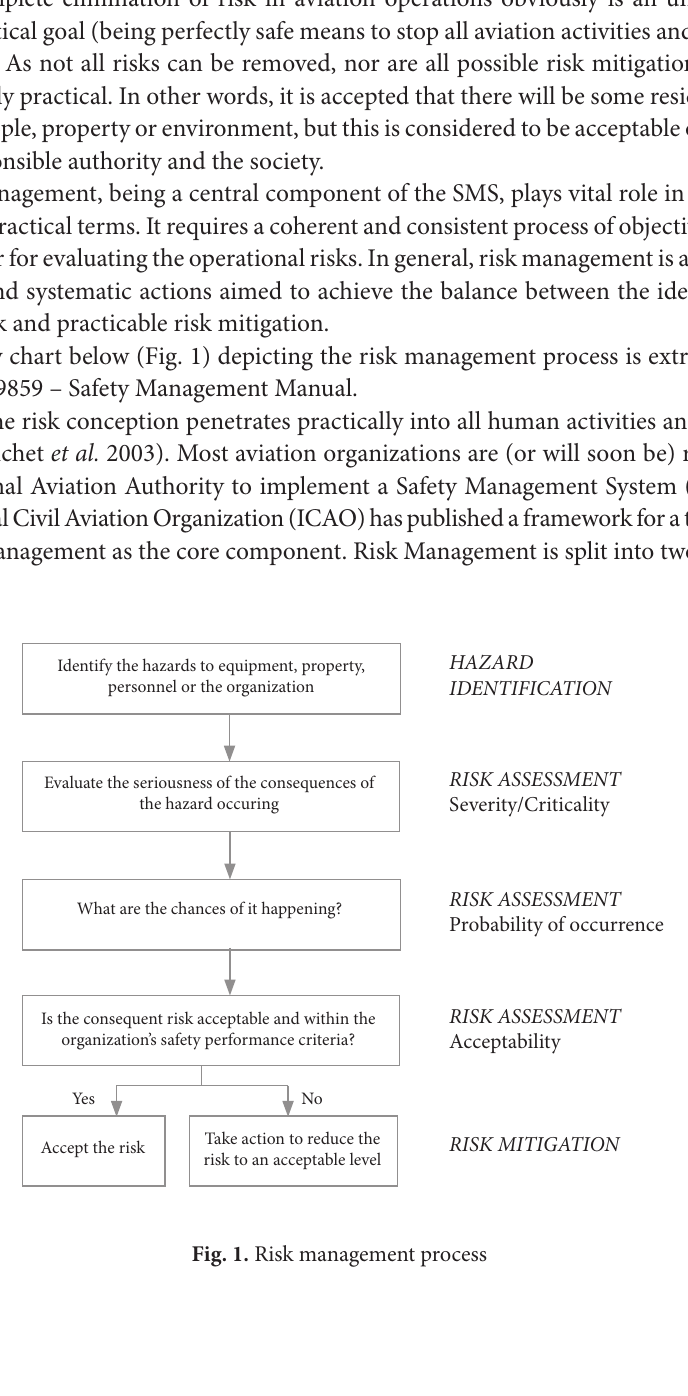
Fig. 1. Risk management process